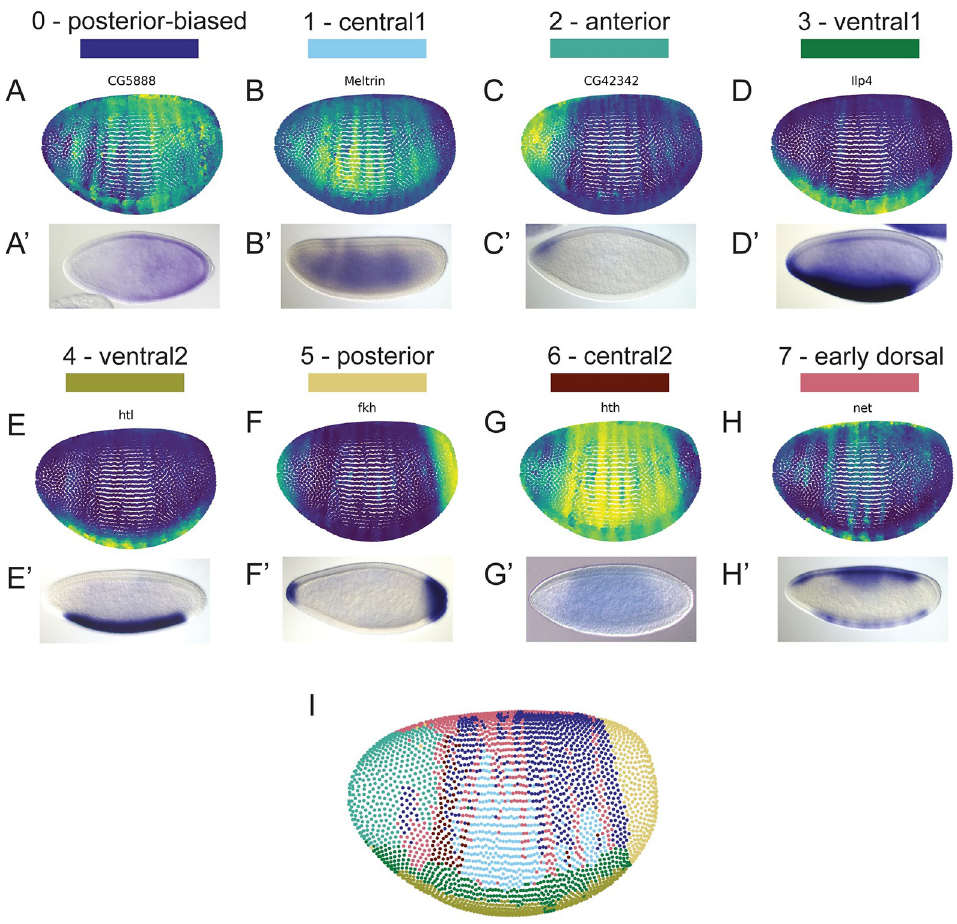
Fig 2. Leiden clusters correspond to spatial regions within the embryo (A-H) Representative virtual in situ hybridizations (top, A-H) for top marker genes representing each cluster as labeled and the corresponding published in situ hybridizations (bottom, A’-H’) from the Berkeley Drosophila Genome Project [39–41]. (I) Projection of nuclei onto a virtual embryo labeled by the Leiden cluster as colored in Fig 1A. Virtual in situ hybridizations and projection of clusters onto a virtual embryo were generated using novoSpaRc [42,